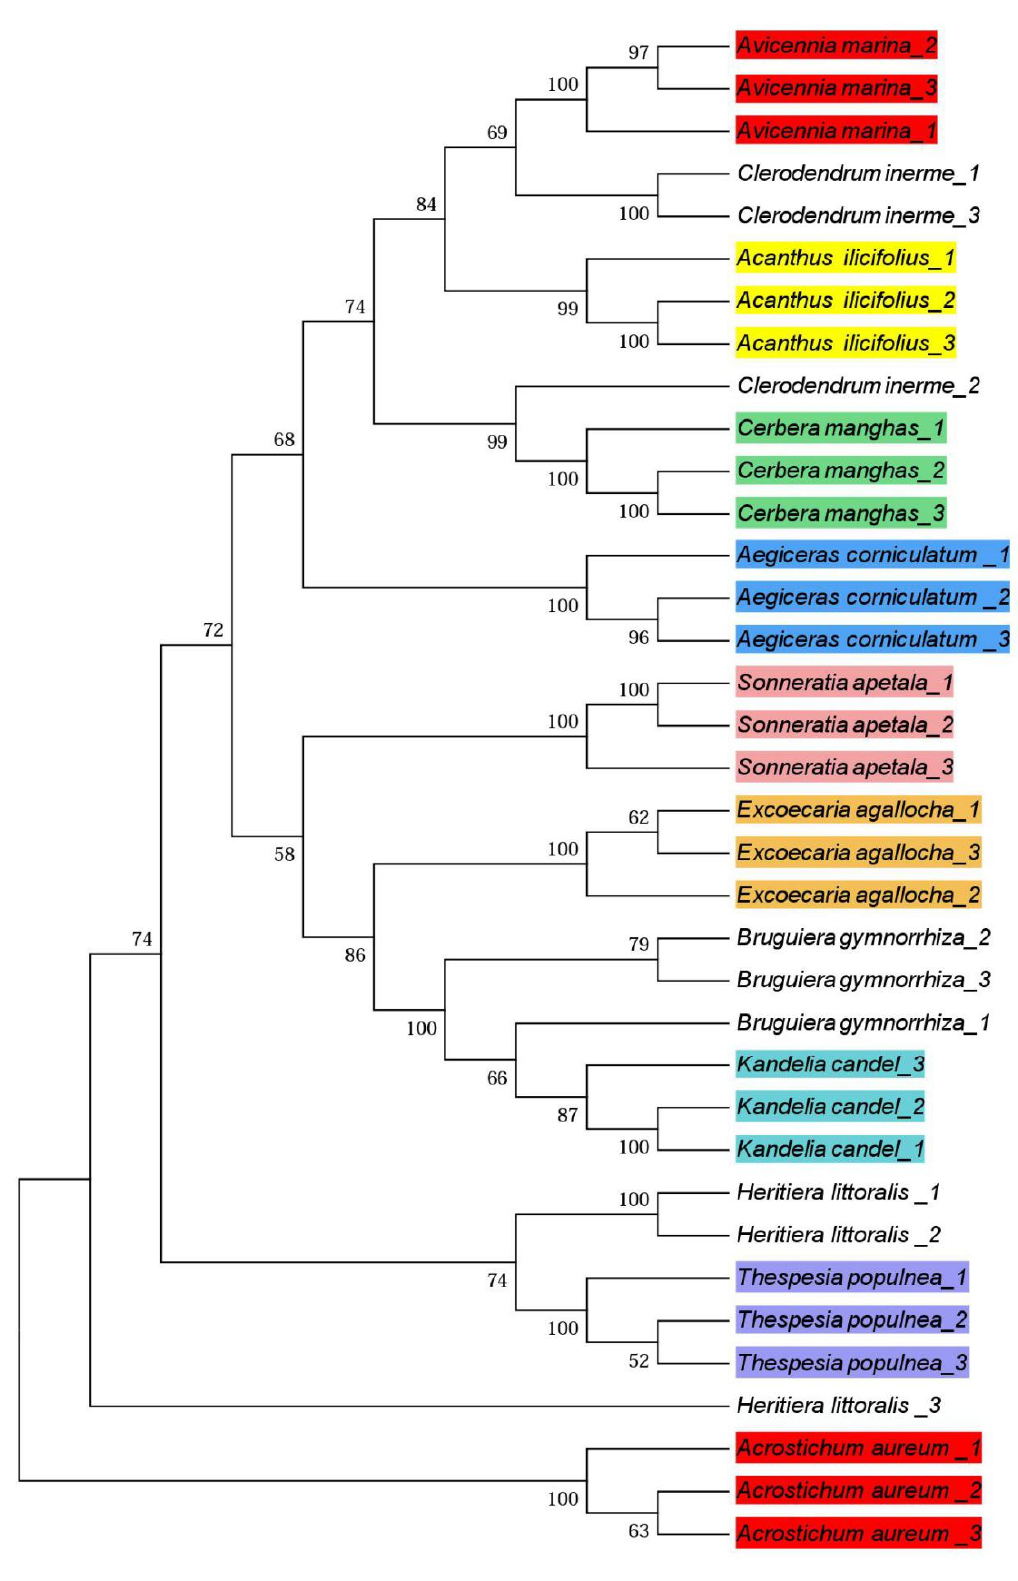
Figure 3. The phylogenetic tree of mangroves in Shenzhen using fragment of matK + rbcL + trnH-psbA + ITS.